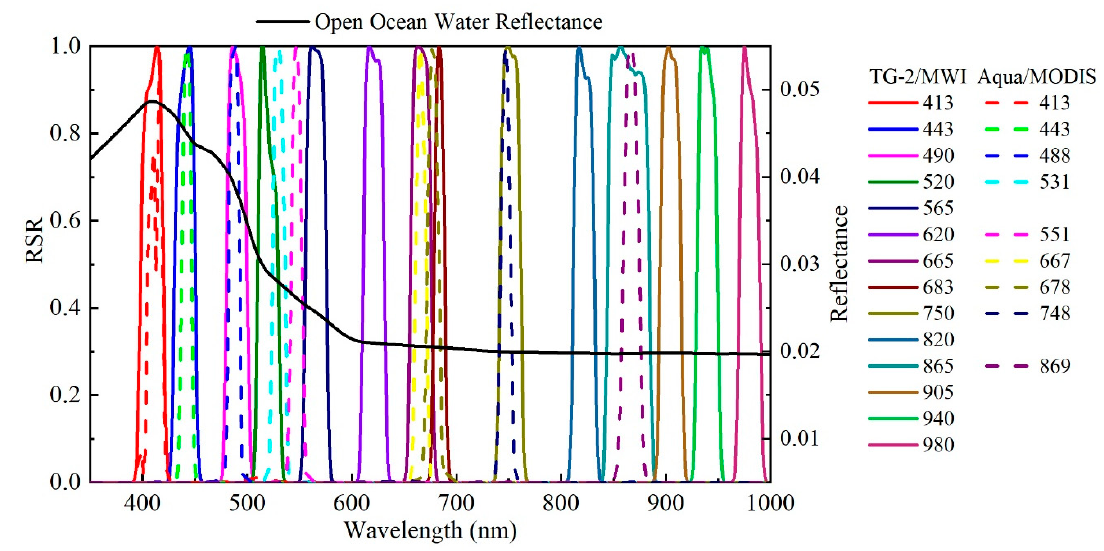
Figure 2. The relative spectral response (RSR) functions of TG-2/MWI (solid lines) and Aqua/MODIS (dashed lines). The black line is open ocean water (case 1 water) reflectance from the United States Geological Survey (USGS) spectral library (http://speclab.cr.usgs.gov/).